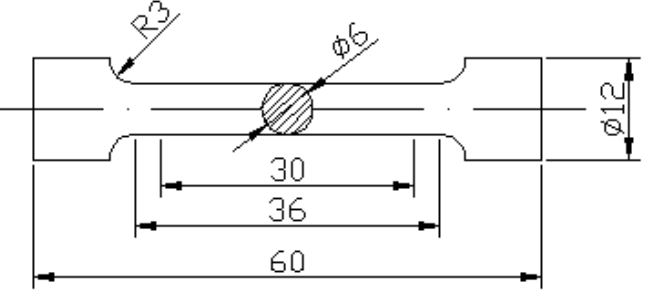
Figure 2. Samples for mechanical property testing (mm).